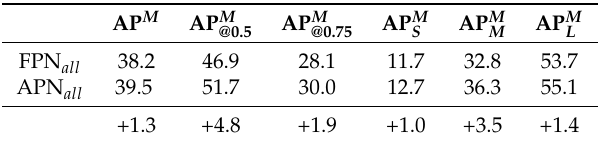
Table 6. Instance segmentation proposals evaluated on the first 1 k 2018 WAD test-dev images, denoted as AP M . All models were trained on the train